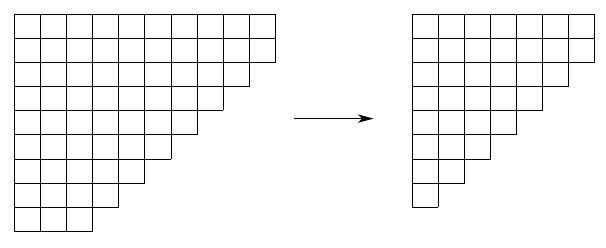
Figure 5 . Equivalent Young